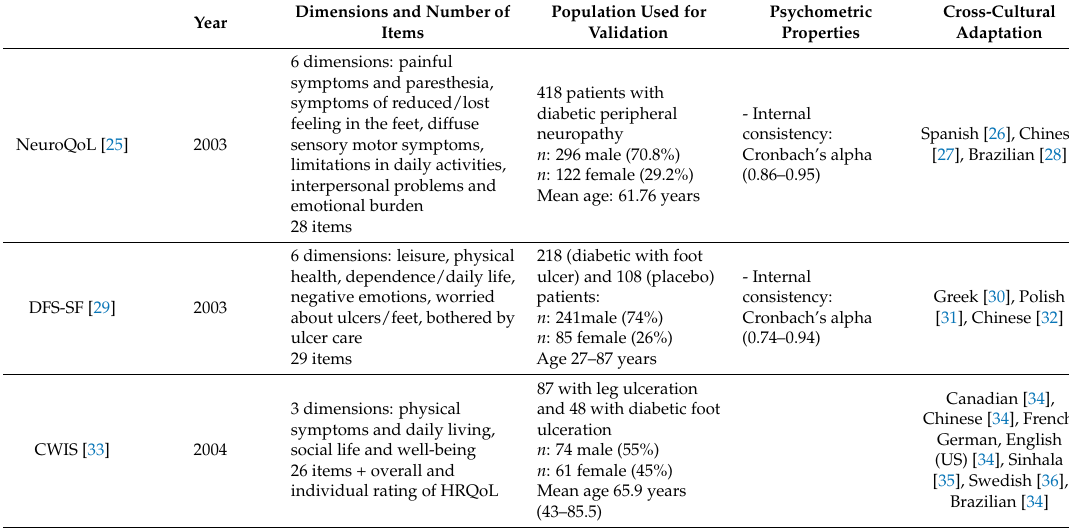
Table 2. Characteristic of all